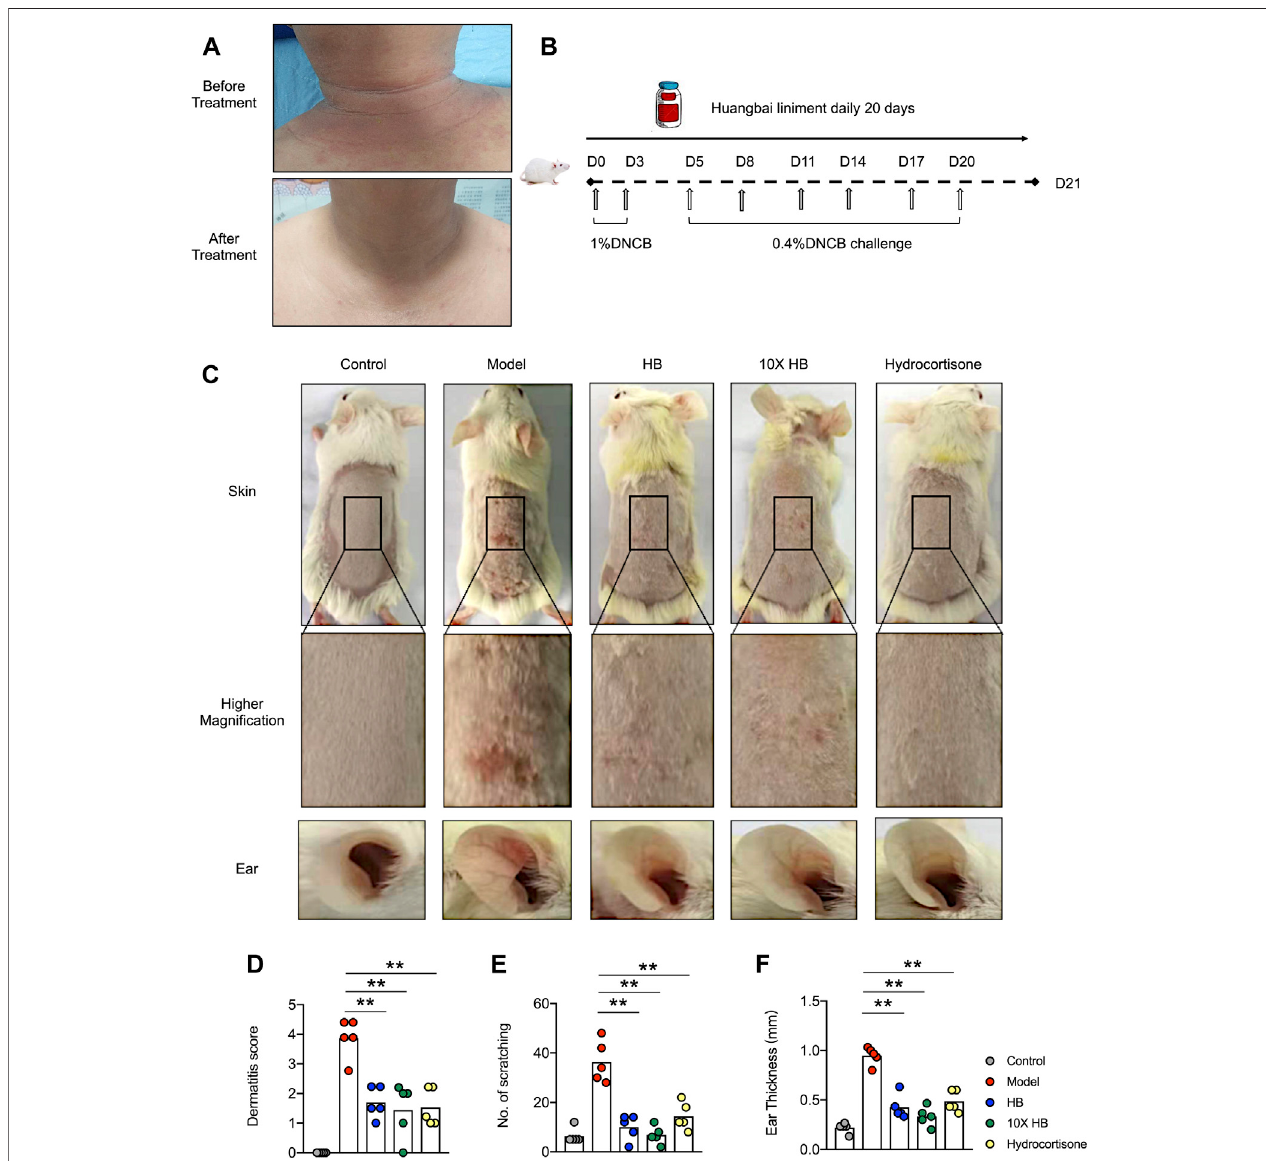
FIGURE 1 | HB ameliorates the symptoms of AD in clinical AD patient and mice. (A) HB was topically applied to a patient with AD 3 times a day for a continuous 15 days.RepresentativeimageofdermatitisonthepatientbeforeandaftertreatmentwithHB.AfterHBapplication,theeczemaontheskinoftheADpatient ’ sneckwas obviously ameliorated and the skin condition altered. (B) Schematic for (C – F). Mice were sensitized with 1% DNCB on dorsal skin at days 0 and 3 and then challenged with 0.4% DNCB on the dorsum of ears at 3 day intervals from days 5 to 20. HB, 10X HB (a 10-fold concentration of HB), hydrocortisone, or PBS was topically applied daily to the dorsal skin of the DNCB-induced mice. (C) Representative images of dorsal skins and ears in each group. The severity of AD was evaluated, and statisticsareshownin (D) . (E,F) Theamountofscratchingandearthicknesseswererecordedattheendpoint,andstatisticsareshown.Eachdotrepresentsonemouse from one of three independent experiments, and bars indicate mean values. Statistical signi fi cance was determined by one-way ANOVA, * p < 0.05, ** p < 0.01.